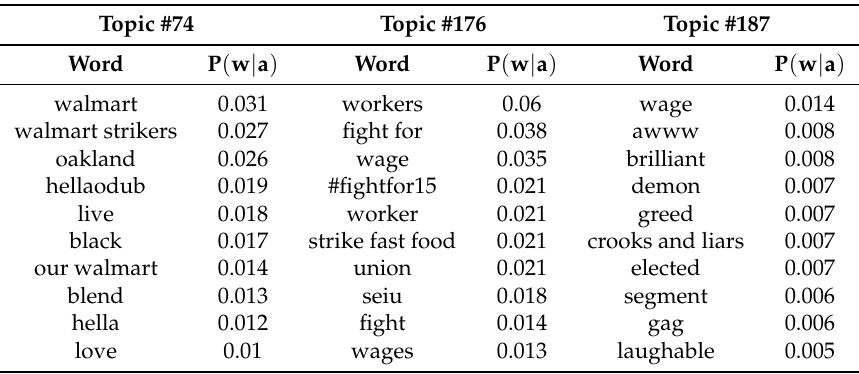
Table 2. “Fight for $15” topic